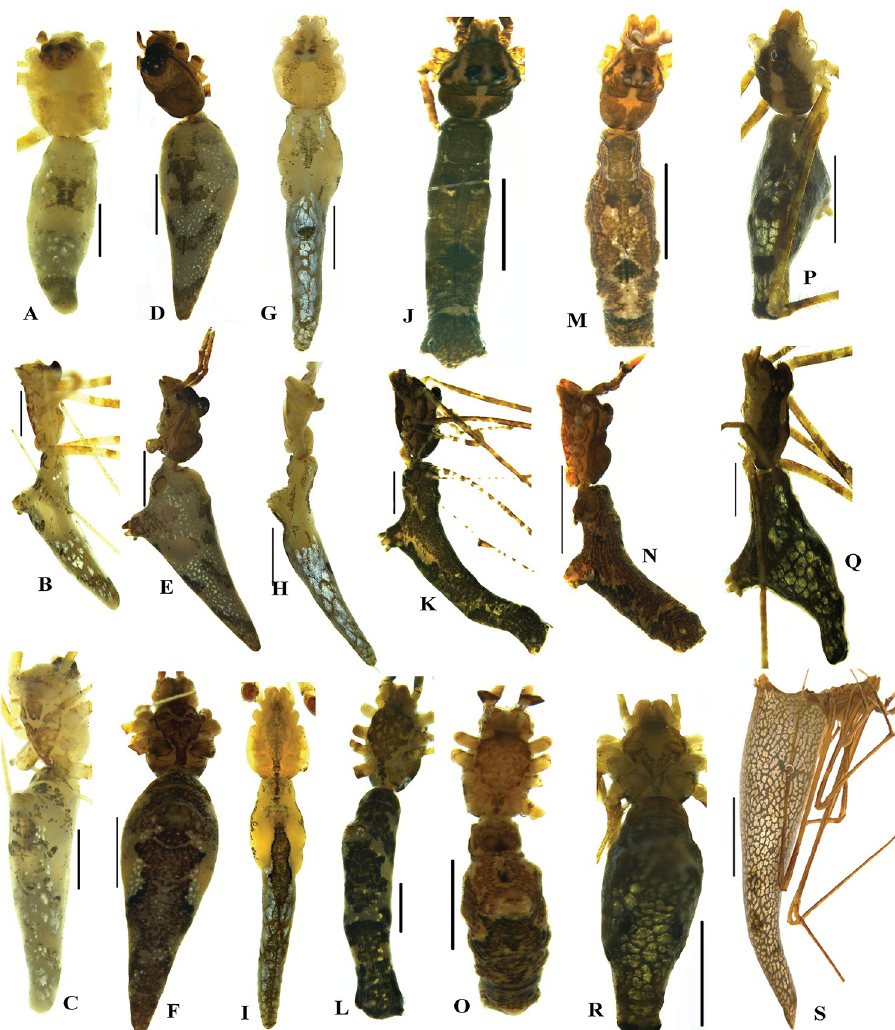
Fig 4. Habitus of Rhomphaea species of Sri Lanka. A–F R . shanthi sp. nov. G–I R . jacko sp. nov. J–O R . marani sp. nov. P–S R . martini sp. nov. A–C, G- I, J–L, P–R male habitus; D–F, M–O, S female habitus. A, D, G, J, M, P dorsal view; B, E, H, K, N, Q, S lateral view; C, F, I, L, O, R ventral view. Scale bars = 1 mm (D–F, B, G–I, J, L, M–O, P, R), 2 mm (S), 0.5 mm (A, C, N, Q). thoracic depression where posterior hump slightly higher. Clypeus slightly convex, moderately slanted, similar color of prosoma, bilateral longitudinal stripes. Labium rectangular, distally not swollen, rebordered, fused with sternum. Sternum reddish brown, longer than wide. Ocu- lar area elevated, projected anteriorly beyond clypeus, medians larger than laterals, measure- ments: AME 0.1, ALE 0.04, PME 0.1, PLE 0.04, PME–PME 0.1, PLE–PLE 0.2, AME–AME 0.1, ALE–PME 0.1, ALE–PLE 0. Opisthosoma slightly cylindrical, boomerang shaped, extending beyond spinnerets, pale yellow with silver and blackish spots, anterior opisthosoma wider, tapered towards the end, posterior tip slightly blunt, opisthosoma length: pedicel–spinnerets 0.9, spinnerets–abdominal tip 1.8, opisthosoma width 0.6. Angle pedicel–spinnerets–posterior opisthosoma tip approximately about 110˚–120˚. Spinnerets in sub-apical region of opistho- soma. Legs pale yellow with reddish brown bands, patella brown. Leg measurements: leg I: